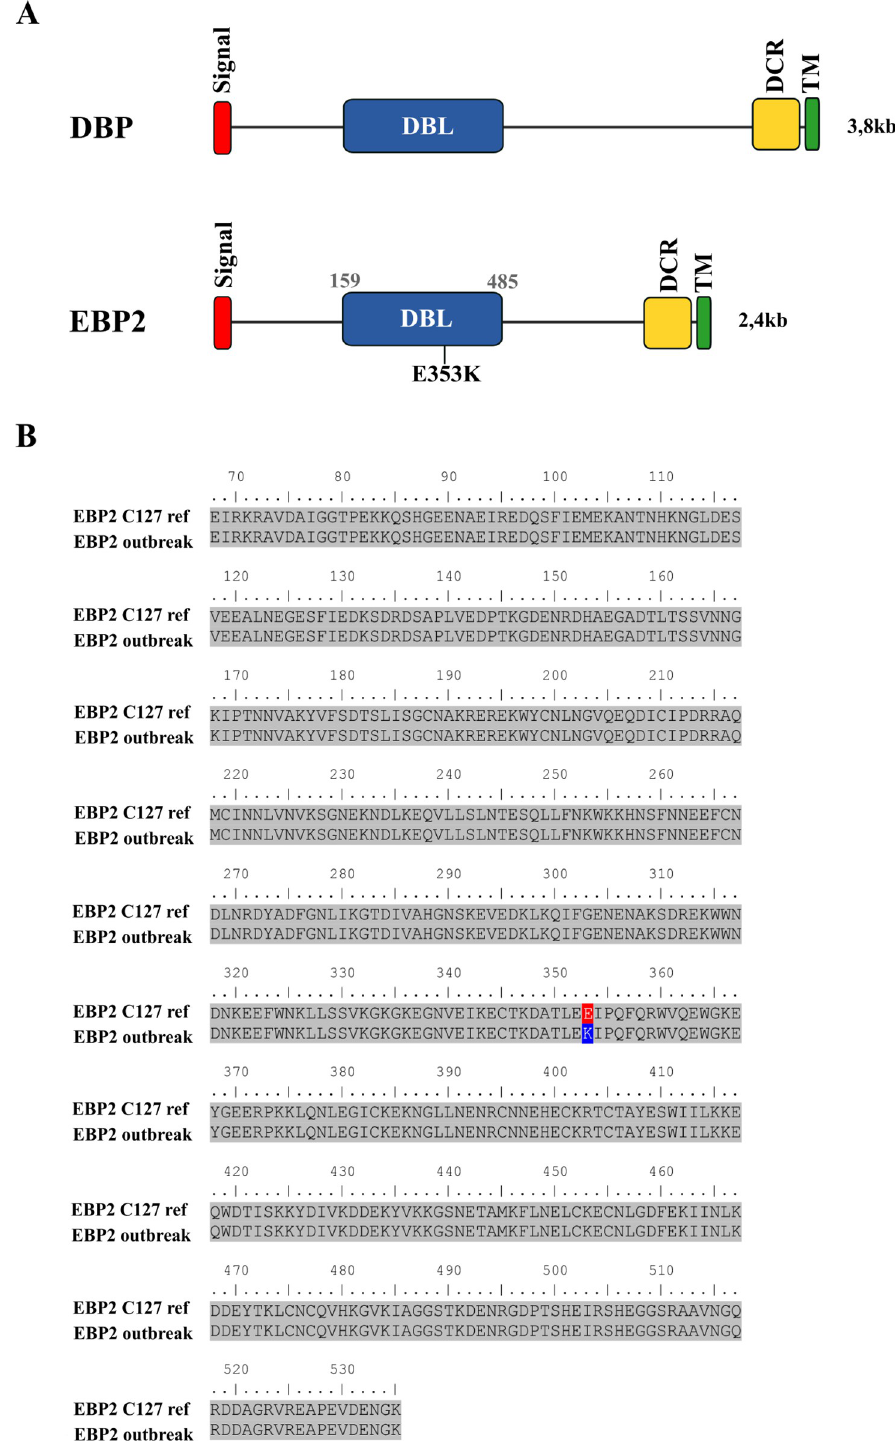
Fig 3. Schematic representation of ebp2 structure and amino acid sequence alignment of P . vivax outbreak isolate. (A) Schematic representation of DBPII and EBP2 domains. The signal peptide (red box), Duffy-binding-like domain (DBL) (blue box), C-terminal cysteine-rich domain (DCR) (yellow box) and transmembrane domain (TM) (green box) are indicated. The polymorphic site in EBP2 is indicated in DBL region (E353K). (B) Amino acid sequence alignment of the DBL domain of P . vivax EBP2 of outbreak isolate (S17 sample). The sequence found at position 353 is highlighted. https://doi.org/10.1371/journal.pntd.0010493.g003 PLOS NeglectedTropical Diseases | https://doi.org/10.1371/journal.pntd.0010493 June 17,